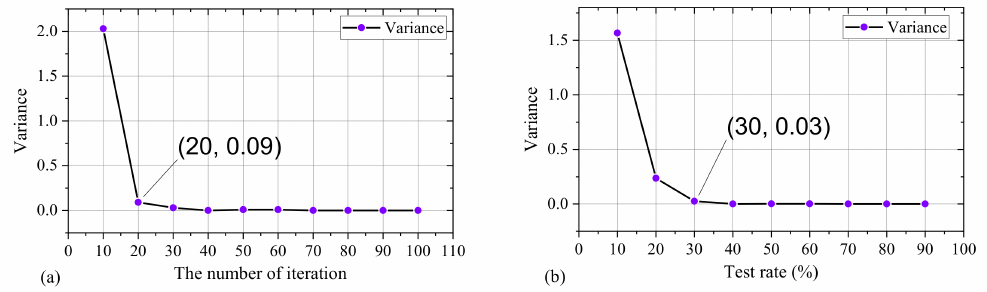
Figure 9. The variance value of diagnosis accuracy for different iterations and test rate, ( a ) The variance value of diagnosis accuracy for different iterations, ( b ) The variance value of diagnosis accuracy for different test